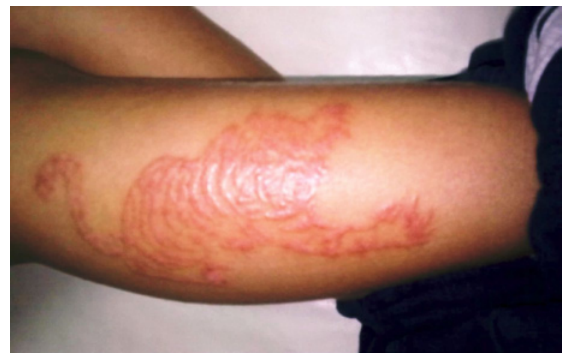
Figure 3. Acute allergic contact dermatitis on the tattoo site of an 8-year-old boy.